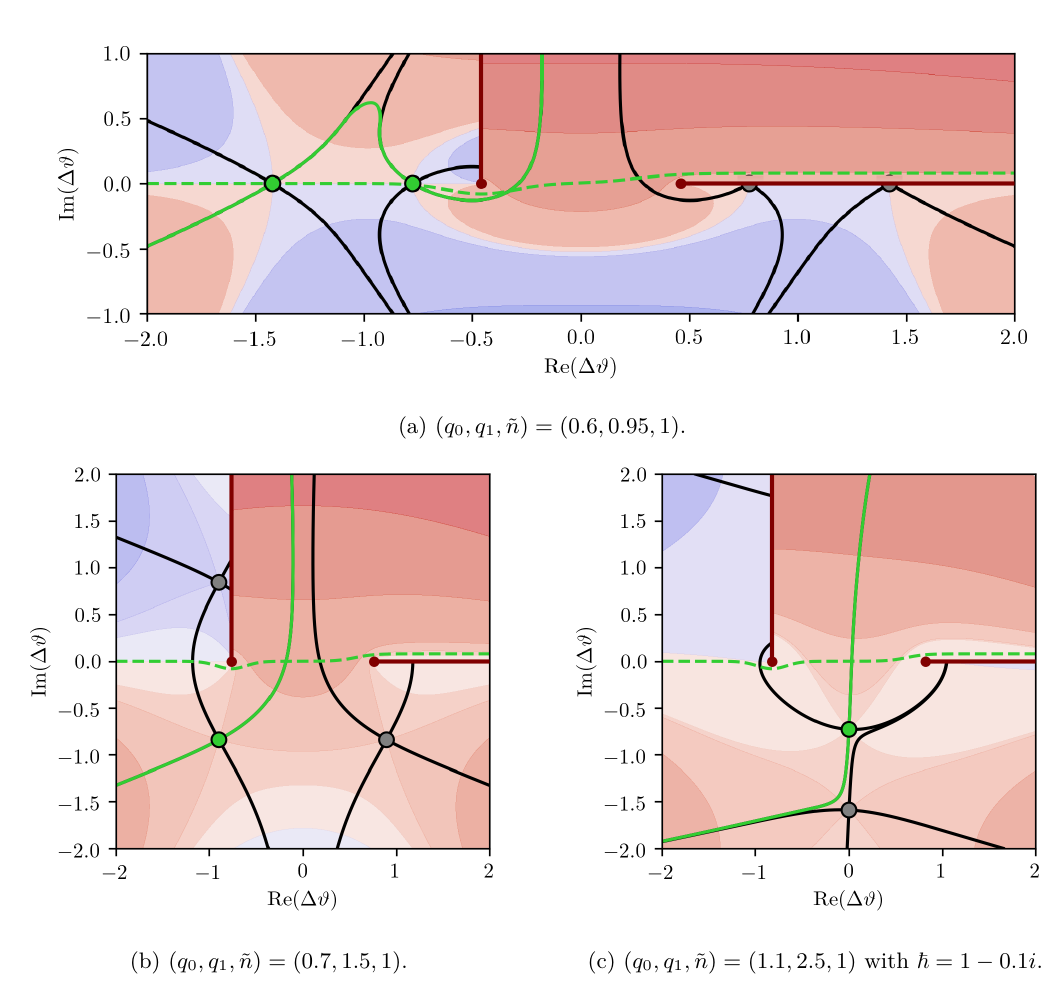
Figure 2. Structure of Φ of eq. (3.22) in the complex- ∆ ϑ plane for (a) q 0 , q 1 < ˜ n , (b) q 0 < ˜ n < q 1 and (c) ˜ n < q 0 < q 1 . In (c) we have set Im( ~ ) < 0 to resolve ambiguities in the Picard-Lefschetz prescription. Regions of red have Re( i Φ) < 0 and regions of blue have Re( i Φ) > 0 : several level- sets of Re( i Φ) are shown with dotted lines. Steepest ascent/descent contours are shown with solid black lines. The initial and deformed ∆ ϑ -contours are shown with dashed and solid green lines,